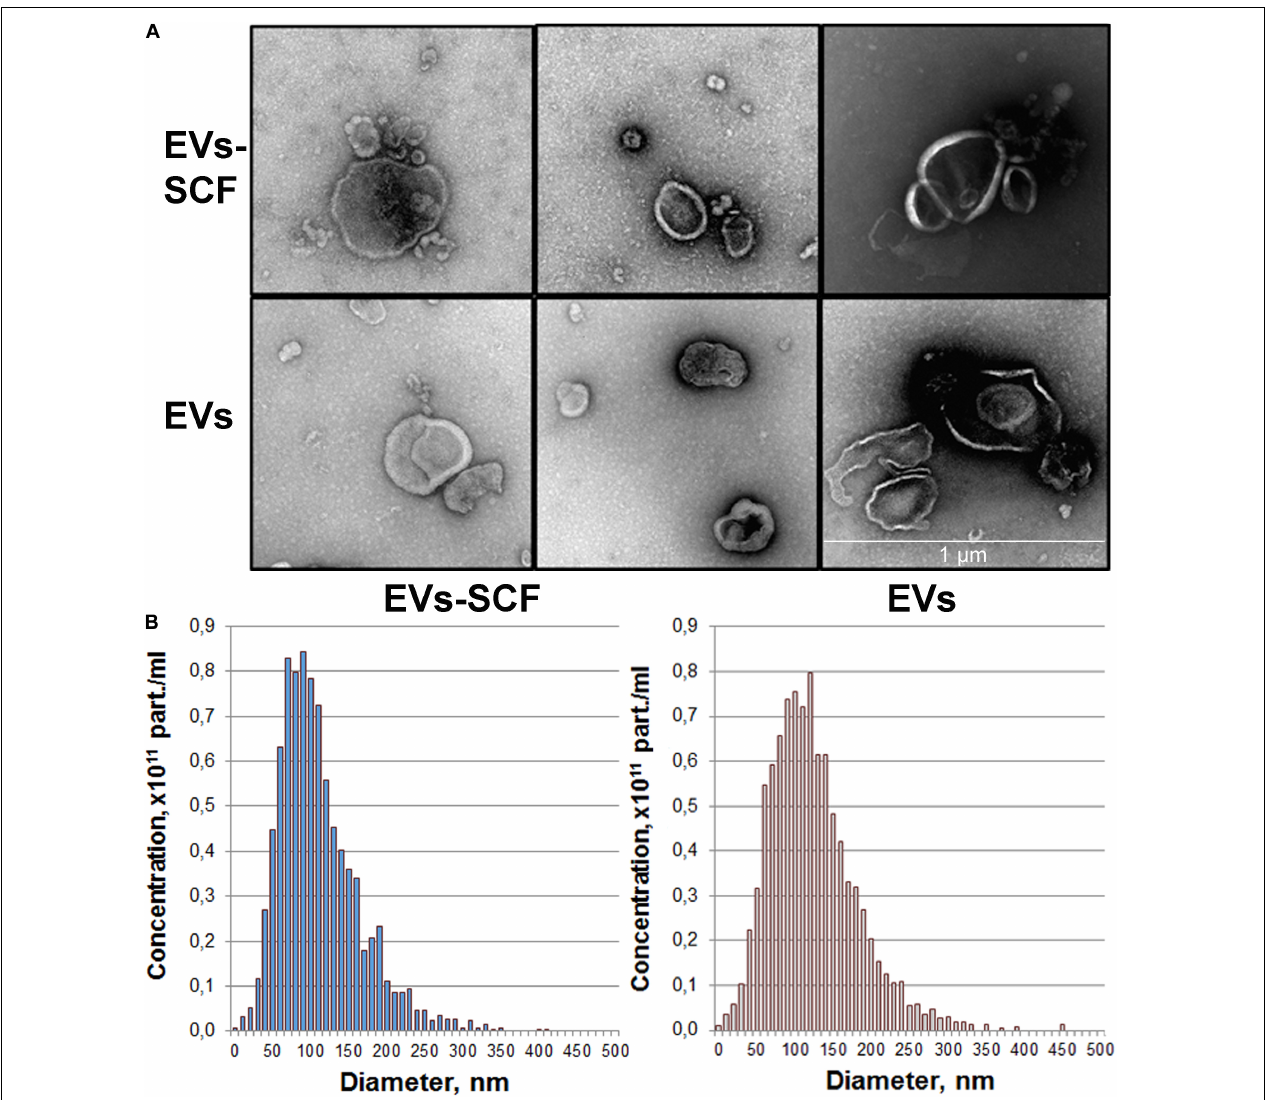
FIGURE 1 | Quality control of extracellular vesicles (EVs) secreted by intact or AAV-transduced mesenchymal stem/stromal cells. (A) Representative transmission electron microscopy images of pooled EVs isolated by ultracentrifugation. Scale bar = 1 µ m. (B) Nanoparticle tracking analysis of MSC extracellular vesicles. Each histogram represents the frequency of EVs in a particular size, ranging from 0 to 500 nm.